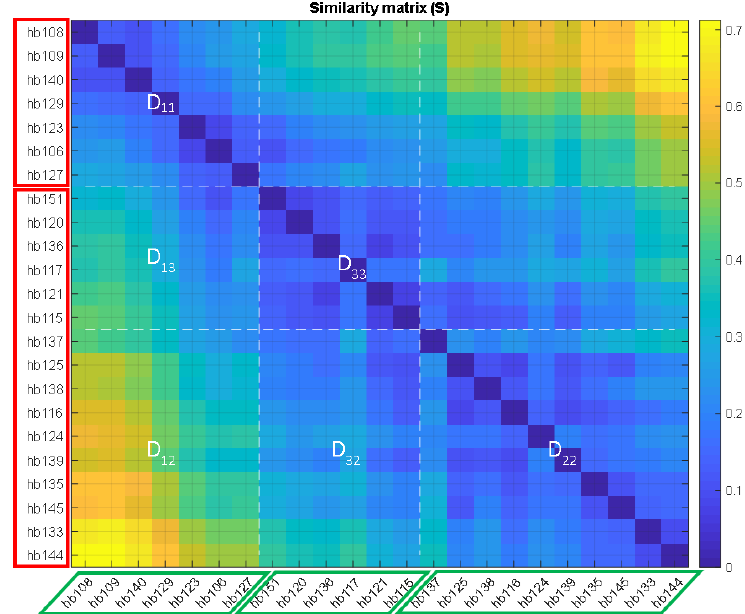
Figure 17. Similarity matrix ( S ) for urban environment at the weekend. White dashed lines separate three clusters of the Q = 3 clustering solution (marked as green rhomboids at bottom), and the Q = 2 solution (also marked on the left-side as red rectangles). Inter ( i = j ) and intra-cluster ( i (cid:54) = j ) distances are highlighted in white and denoted as D ij